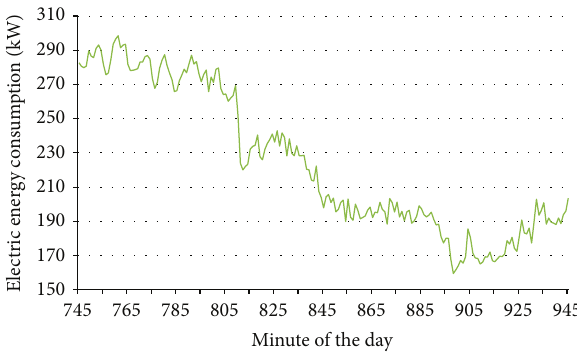
Figure 2: Load curve fragment with a sampling time of 1